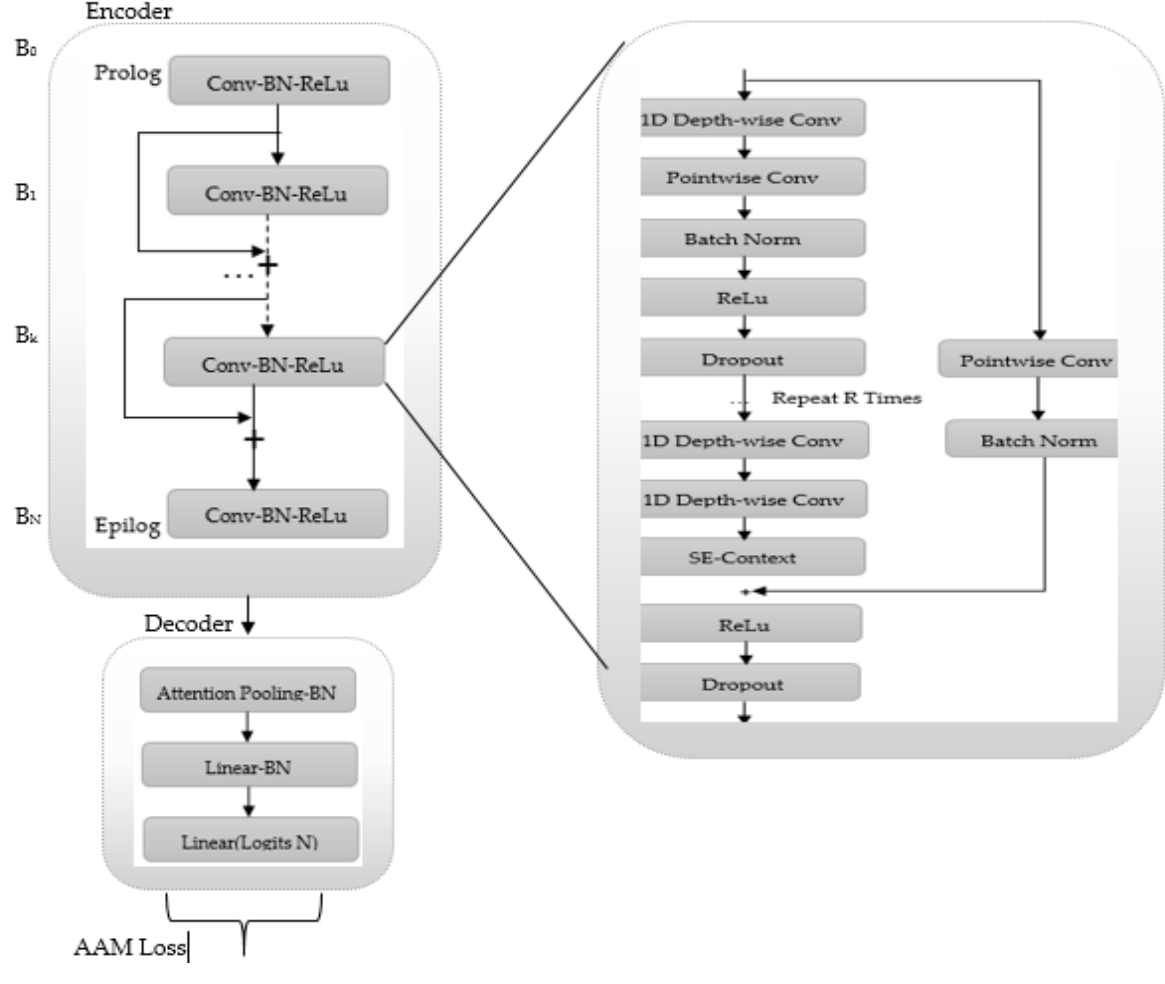
Figure 5. TitaNet Architecture [10].